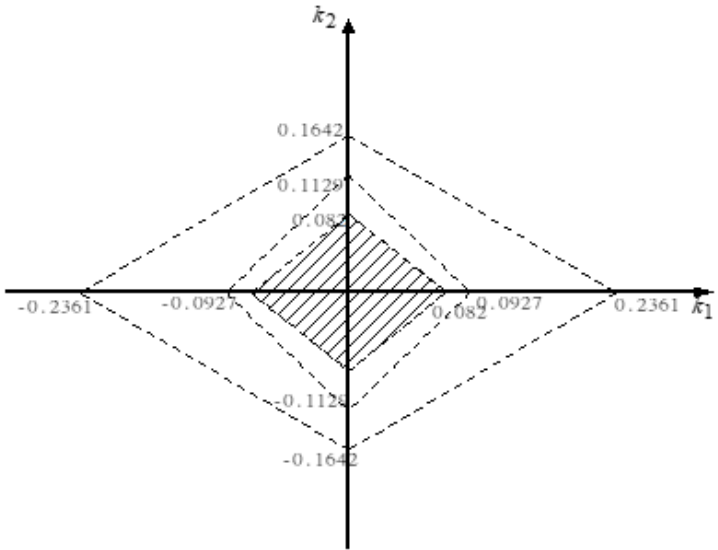
and k for the observer-based controller of example 1. Figure 4. The admissible region k 1 and k 2 for the observer-based controller of example 1 2